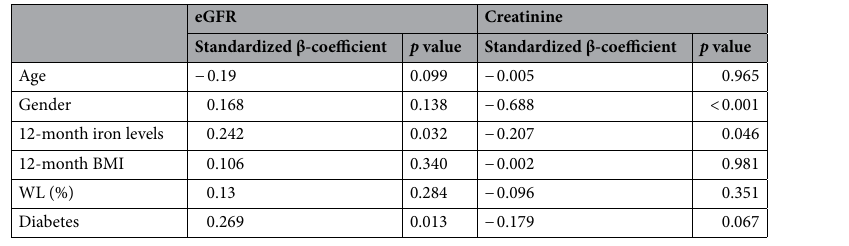
Table 3. Multiple regression analyses on associations of independent variables with kidney function (i.e., eGFR and creatinine) at 12-month follow-ups, expressed as standardized effect sizes (β-coefficient). eGFR, estimated glomerular filtration rate; BMI, body mass index; WL (%), weight loss percentage.